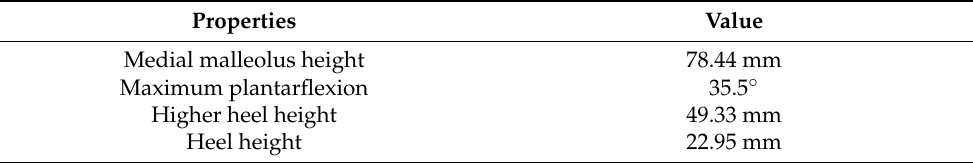
Table 1. Average body size of adults aged between 20 and 59 [25].